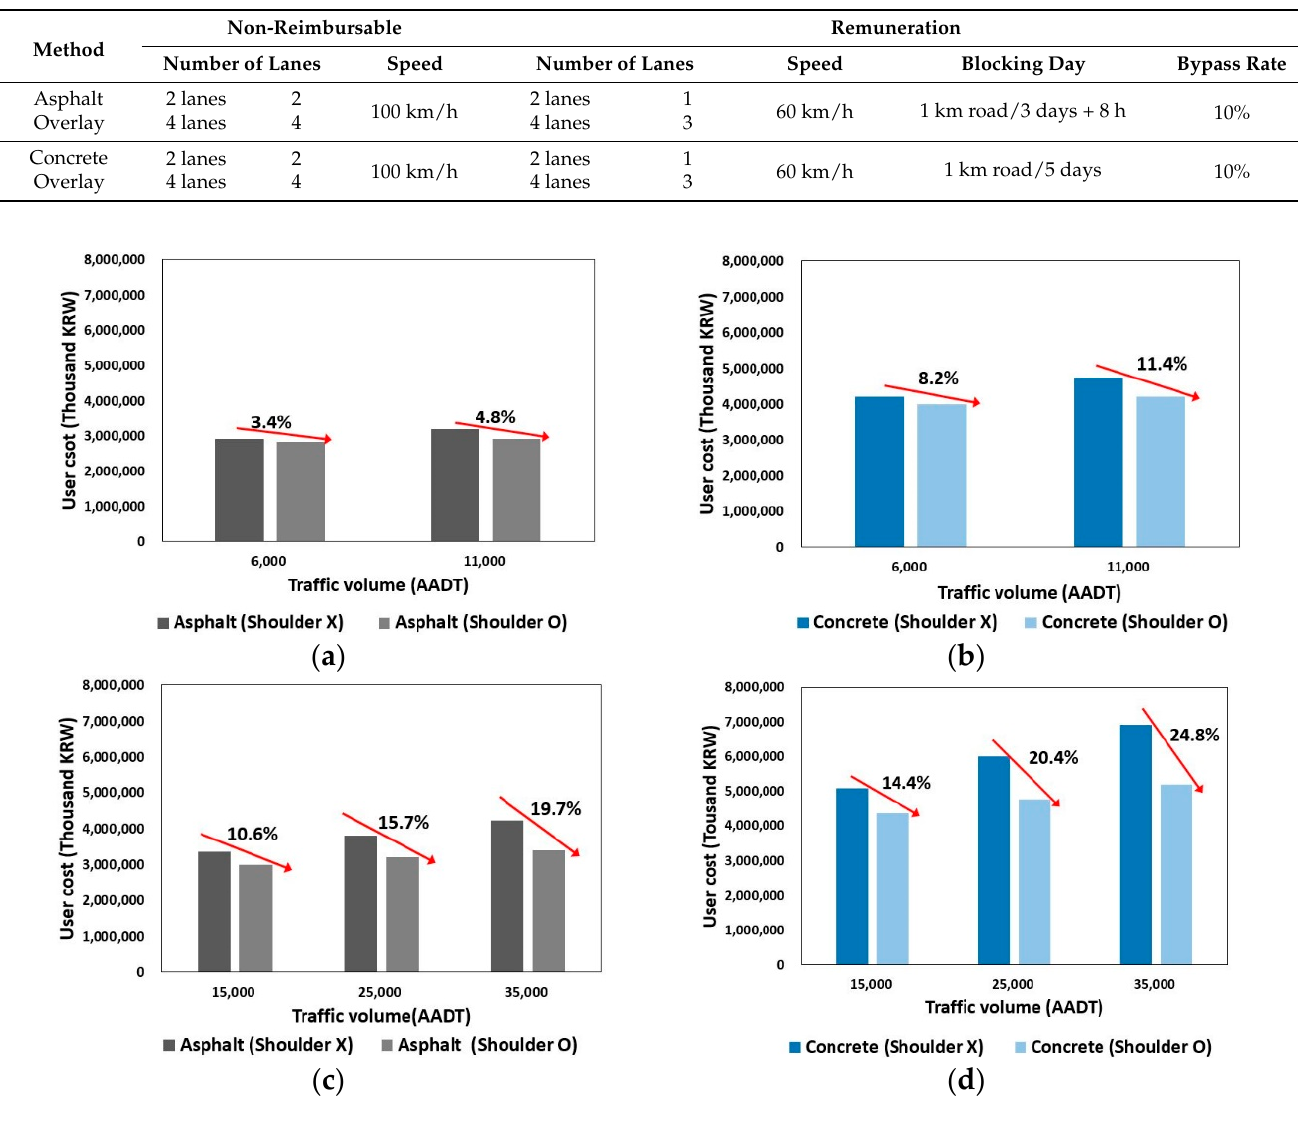
Figure 8. Comparison of the total construction cost of overlay using the shoulder. ( a ) Comparison of total construction user cost using asphalt overlay shoulder (lane 2). ( b ) Comparison of total construction user cost using concrete overlay shoulder (lane 2). ( c ) Comparison of total construction user cost using asphalt overlaid shoulder (lane 4). ( d ) Comparison of total construction user cost using concrete overlaid shoulder (lane 4).